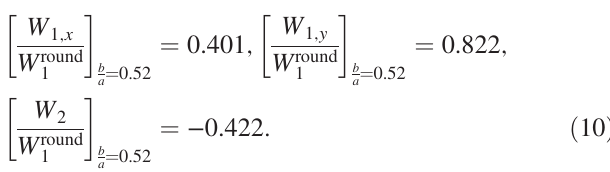
Table. III summarizes the growth rates and real tune ance (RW) and geometric broad band impedance (BB).